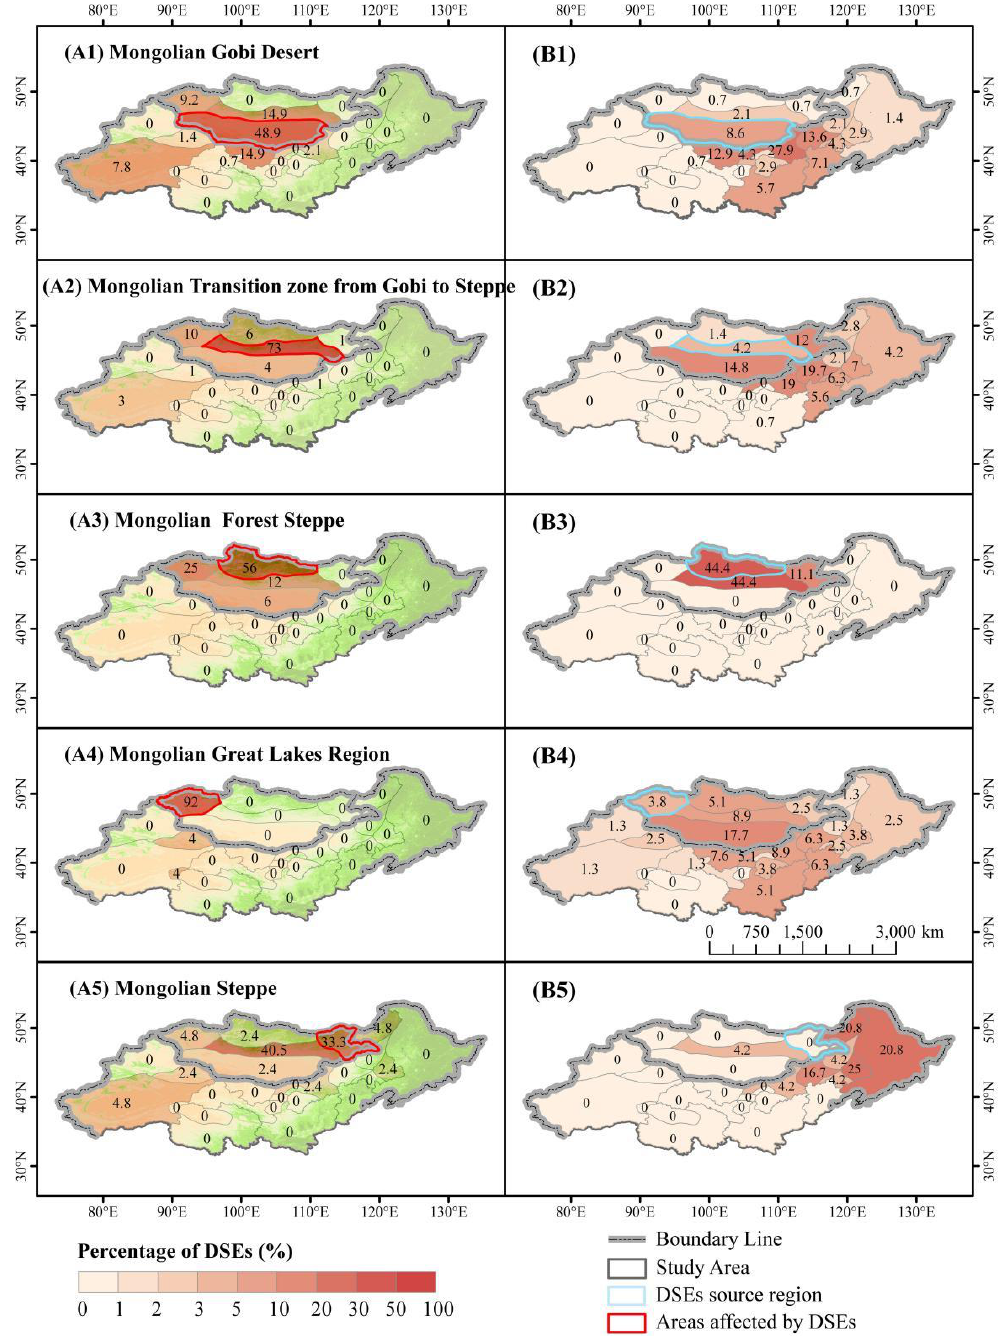
Figure 5. Statistical map of the percentage of sources ( A ) and affected areas ( B ) of DSEs in Mongolia, 2016–2020. On the left ( A ), the areas enclosed by red boxes are the areas affected by the DSEs, and the numbers indicate the percentage of DSEs affecting the red box area. On the right ( B ), the areas enclosed by blue boxes are the DSEs’ source regions, and the numbers indicate the percentage of DSEs affected by the region in the blue